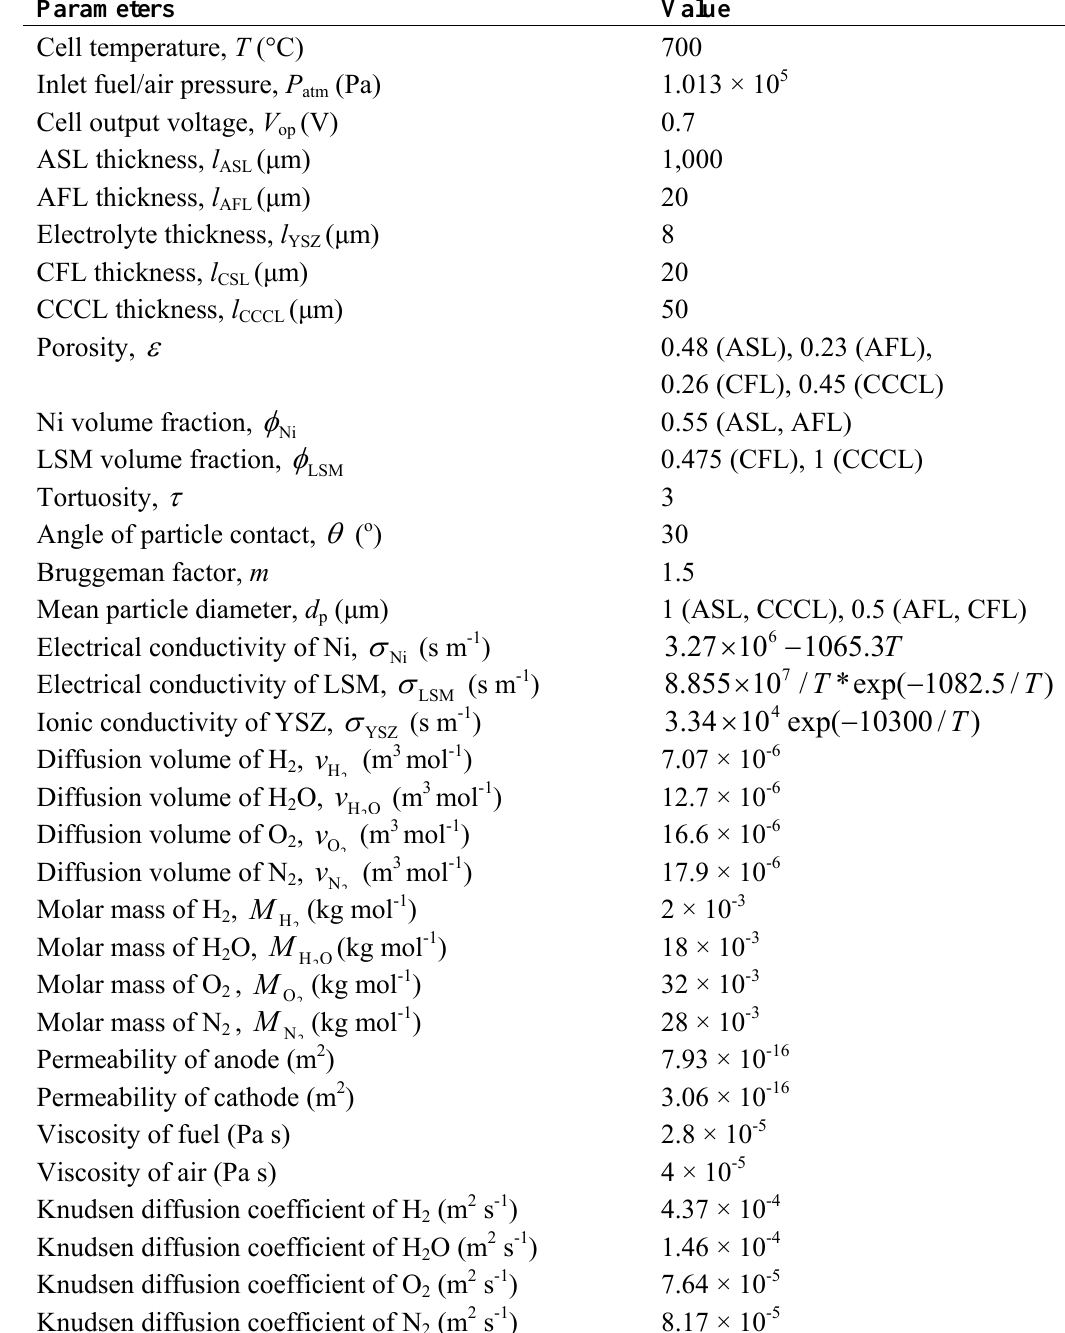
Table 1. Geometric, material and operational parameters for SOFC with functional layers.